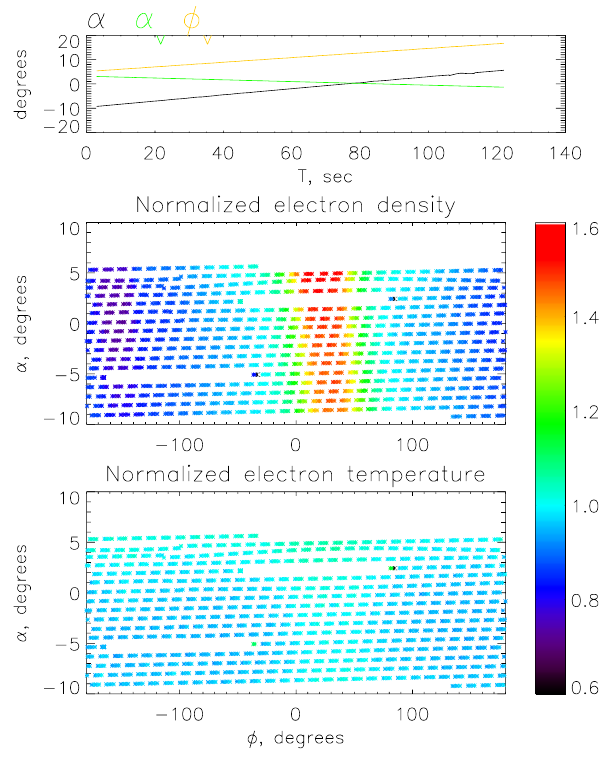
Fig. 8. “Maps” of plasma parameters in the vicinity of the Astrid-2 satellite, derived from the sweep measurements between 12:39 and 12:41 UT. The upper panel presents variation of the angle between B and the spin plane α during the period when the sweep data were taken, the angle between v and the spin plane α v , and the angle between the projections of B and v in the spin plane φ v . Two panels below show normalized electron density and electron temperature as functions of spin phase φ and α